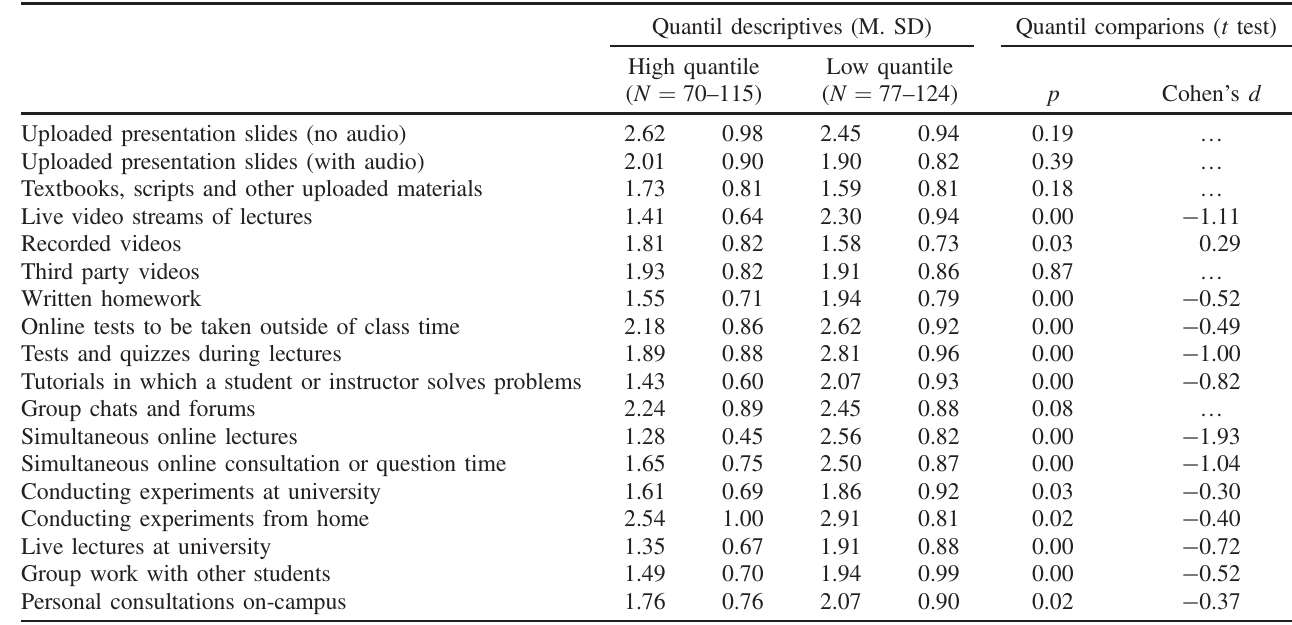
TABLE X. Course elements that are perceived to be helpful: Comparison between students with a high and low preference for synchronous or simultaneous courses (generated from a post-hoc quantile